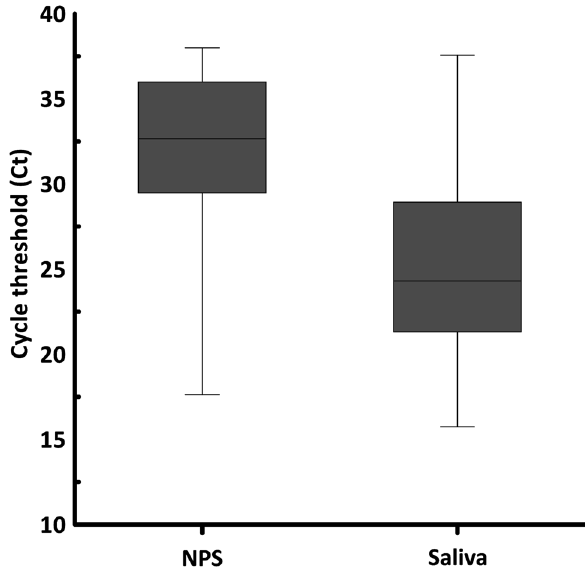
Figure 1. Comparison of Real-Time RT-PCR results (viral load as measured by Ct value) of 72 pair of nasopharyngeal swab and saliva samples on day zero.